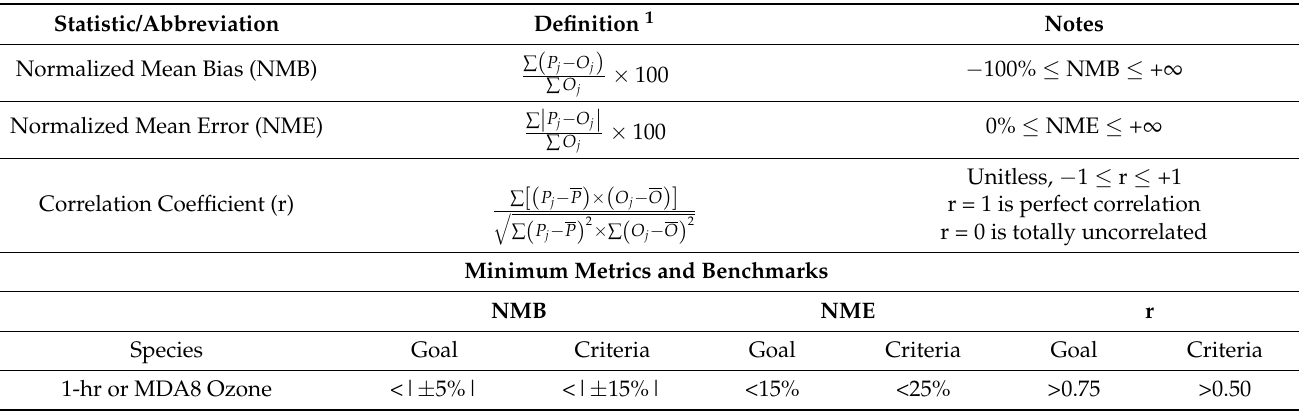
Table 1. Statistical measures, goal and criteria thresholds for ozone model performance. Excerpted from Emery et al. [29].